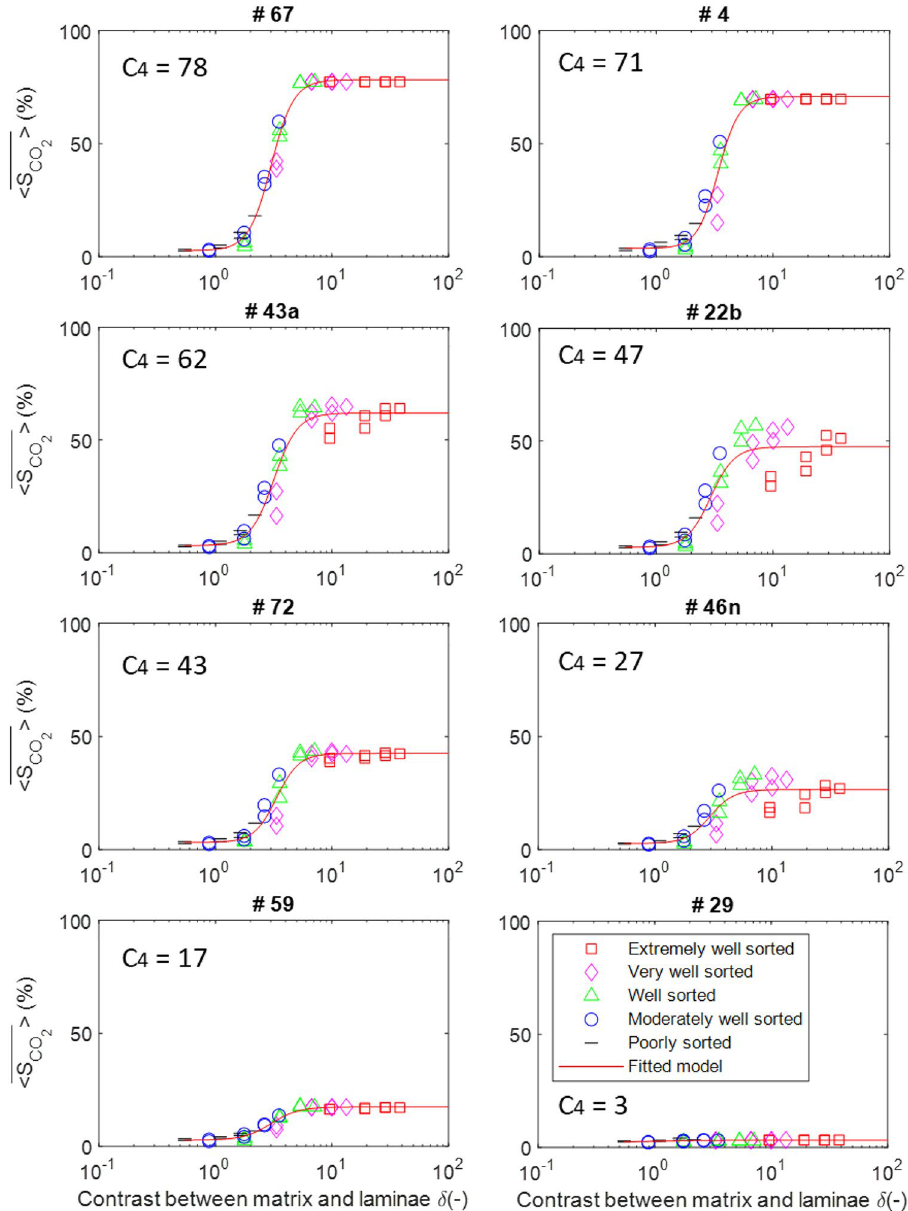
Figure 5. Mean domain CO 2 saturation data and the corresponding fitted model for eight selected BAMs. The different symbols represent different grain sorting. The fitted model is shown with a red line. The value of the fitted parameter C 4 for each BAM is also